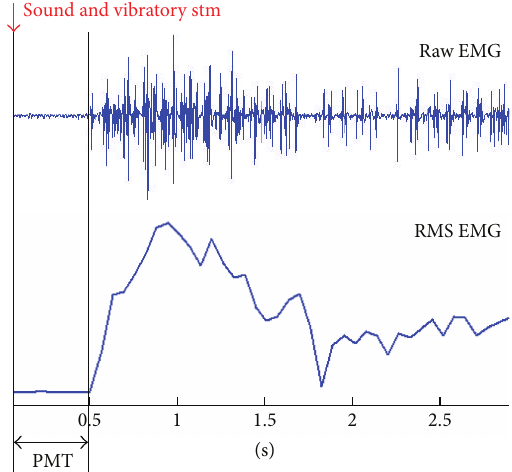
Figure 1: PMT extraction